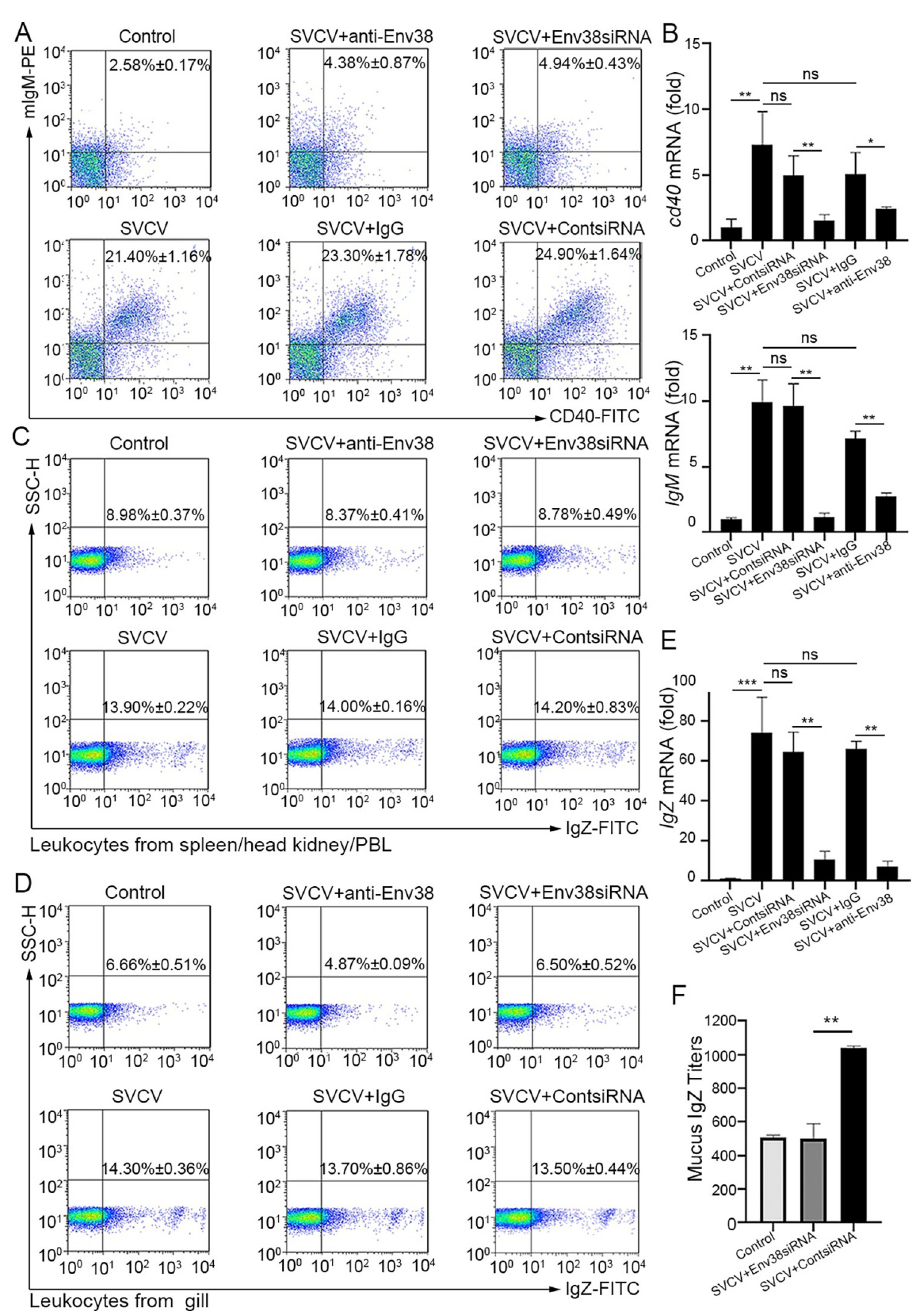
Fig 8. Evaluation on the functional role of Env38 in CD4 + T cell-initiated B cell activation. (A and B) In vivo examination on the activation of IgM + B cells of zebrafish stimulated with SVCV (10 5 TCID 50 ) and impaired by blockade or knockdown of Env38 with i.p administering anti-Env38 Ab (10 μ g/fish) or Env38siRNA-LV (1 × 10 6 TU/ fish) as determined by the percentage of mIgM + CD40 + B cells with mouse anti-mIgM (1:2,000) and rabbit anti-CD40 (1:500) through FCM analysis (A) and the transcriptional expression levels of cd40 and IgM genes through RT-qPCR (B). (C-F) In vivo examination on the activation of IgZ + B cells of zebrafish stimulated with SVCV (10 5 TCID 50 ) and impaired by blockade or knockdown of Env38 with i.p administering anti-Env38 Ab (10 μ g/fish) or Env38siRNA-LV (1 × 10 6 TU/fish) as determined by the percentage of IgZ + B with rabbit anti-IgZ (1:500) in leukocytes from spleen, head kidney and peripheral blood (C) and from gill (D) through FCM analysis, the transcriptional expression of IgZ genes via RT-qPCR (E) and the mucus IgZ antibody production by ELISA (F). Nonrelated control groups were administered with isotype IgG or scrambled siRNA-LV. Negative control groups received mock PBS. The data presented in each block diagram indicated the average percentage of IgM + CD40 + B or IgZ + B cells in each treatment group. RT-qPCRs